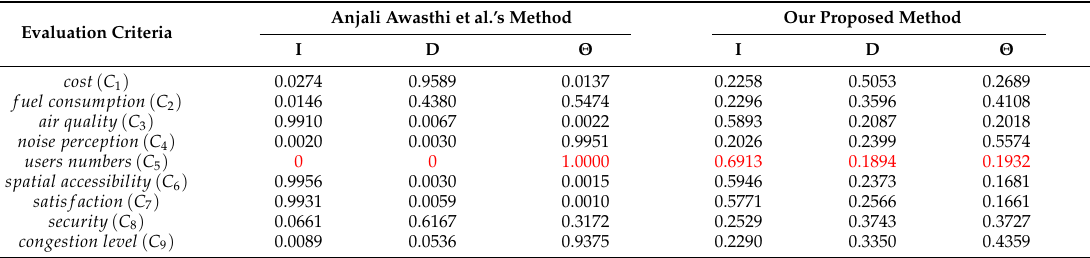
Table 8. The testing BPA fusion results.